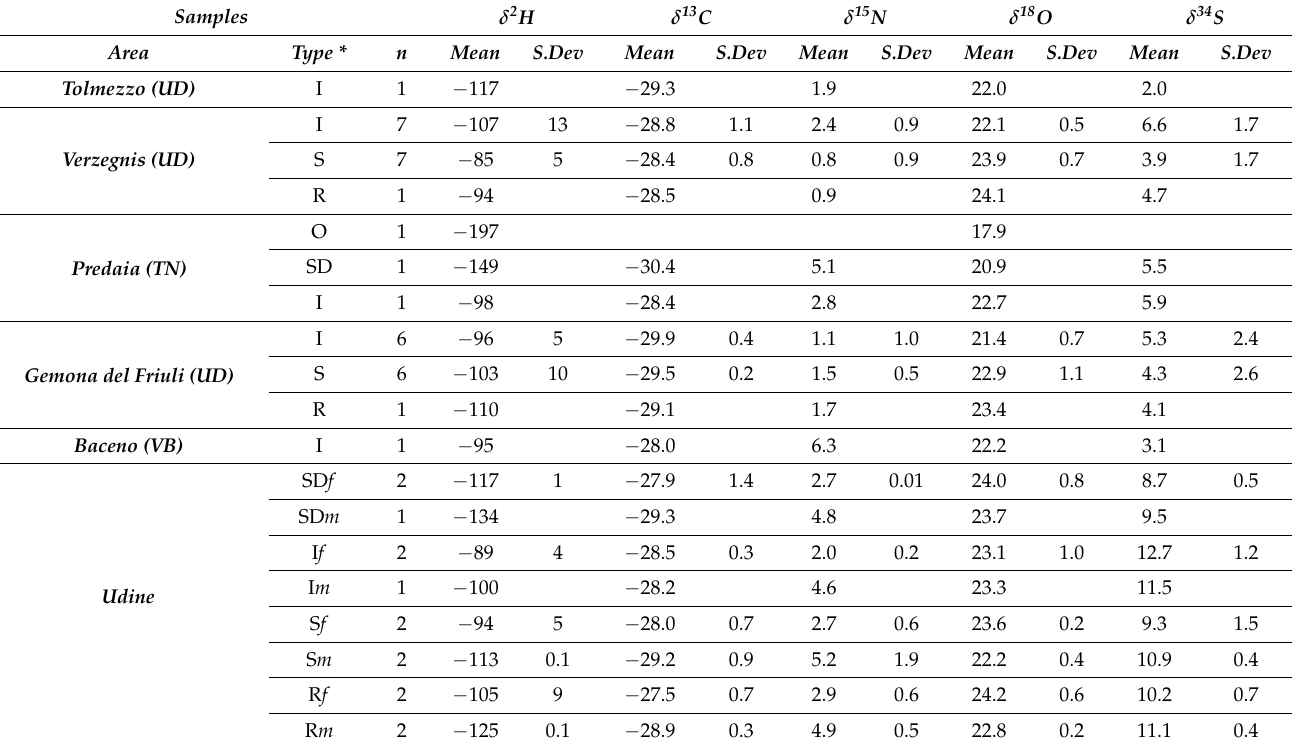
Table 1. Stable isotope ratios (mean values and standard deviation (S.Dev) expressed in ‰) of Italian industrial hemp samples ( Cannabis sativa L.) ordered according to the latitude of the sampling areas (from the highest to the lowest); n refers to the number of samples